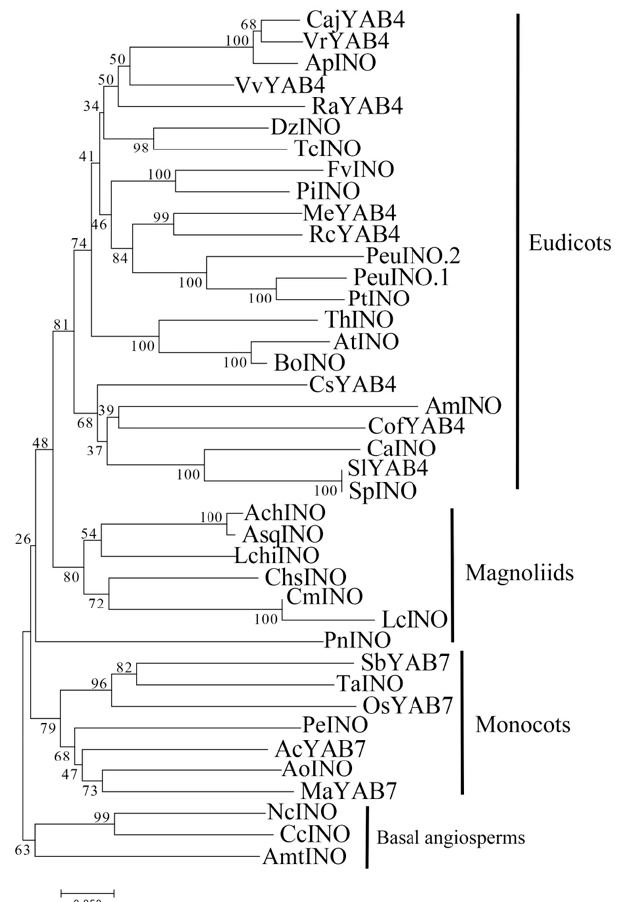
Figure 5. Phylogenetic tree of INO proteins from magnoliids and various angiosperms. The phylogenetic tree was constructed with the NJ method using MEGA 7.0 software. Bootstrap analysis was conducted with 1000 replications. The same acronym represents the same species: Cm: C. micranthum ; Chp: C. praecox ; Lc: L. cubeba ; Chs: C. salicifolius; Pbo: P. bournei ; Pn: P. nigrum ; Lchi: L. chinense . The protein accession list for related proteins is collected in Table S1.